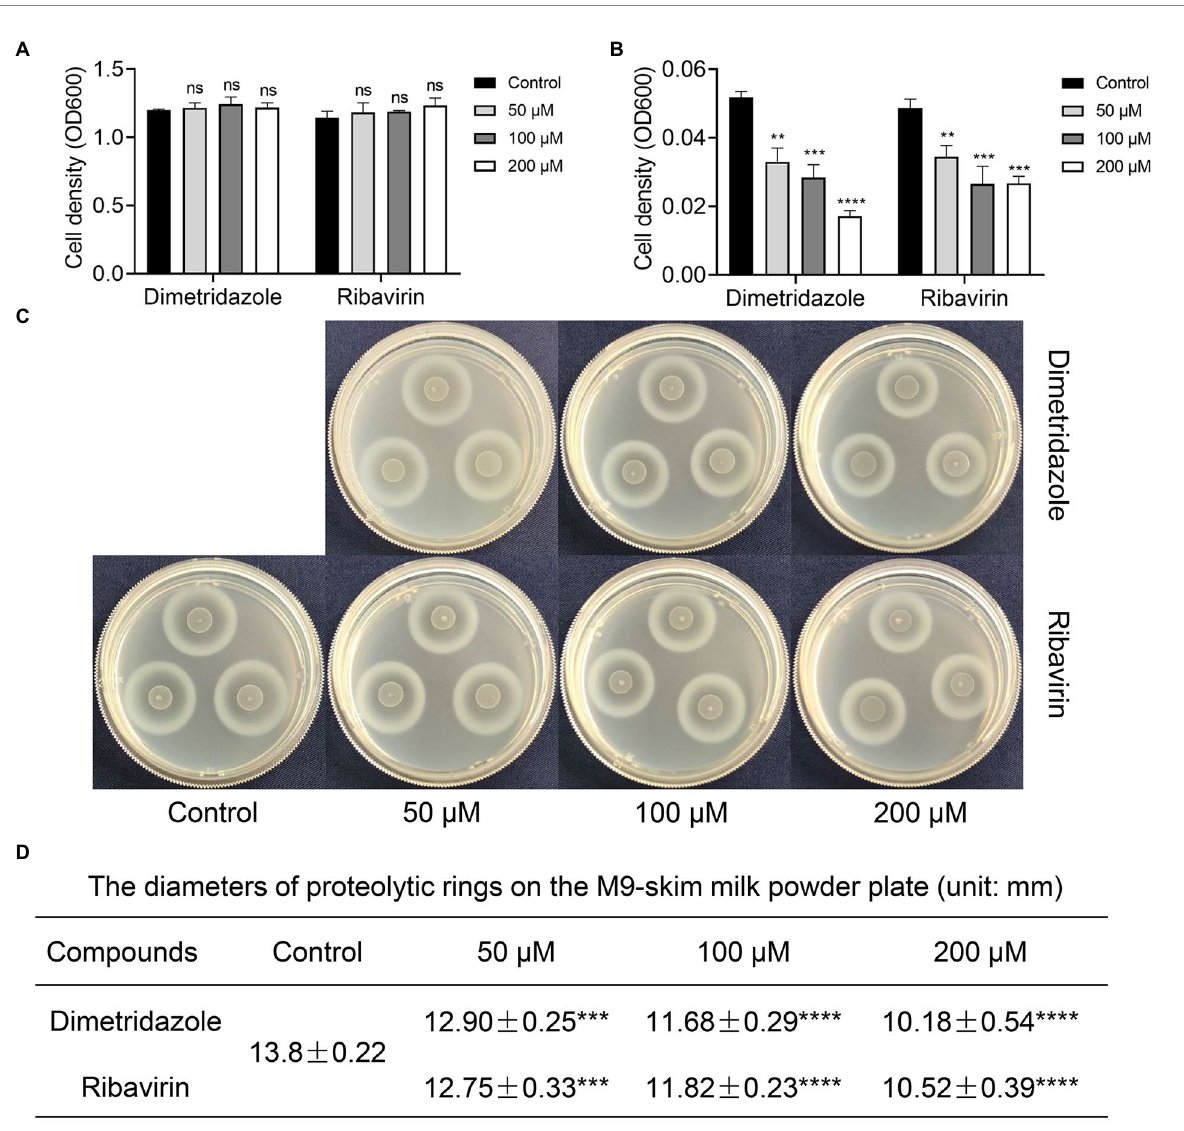
FIGURE 2 Effects of Dimetridazole and Ribavirin on the growth of Pseudomonas aeruginosa PAO1. (A) Growth of P. aeruginosa PAO1 in LB broth containing different concentrations of Dimetridazole or Ribavirin. (B) Growth of P. aeruginosa PAO1 in M9-adenosine broth containing different concentrations of Dimetridazole or Ribavirin. (C) Growth of P. aeruginosa PAO1 on M9-skim milk plate containing different concentrations of Dimetridazole or Ribavirin. (D) The diameters of proteolytic rings formed by P. aeruginosa PAO1 colony on M9-skim milk plate (unit: mm). Data shown are the means ± SD of at least six independent experiments. One-way ANOVA test compared to the control, ** p < 0.01, *** p < 0.001, and **** p < 0.0001. ns, not